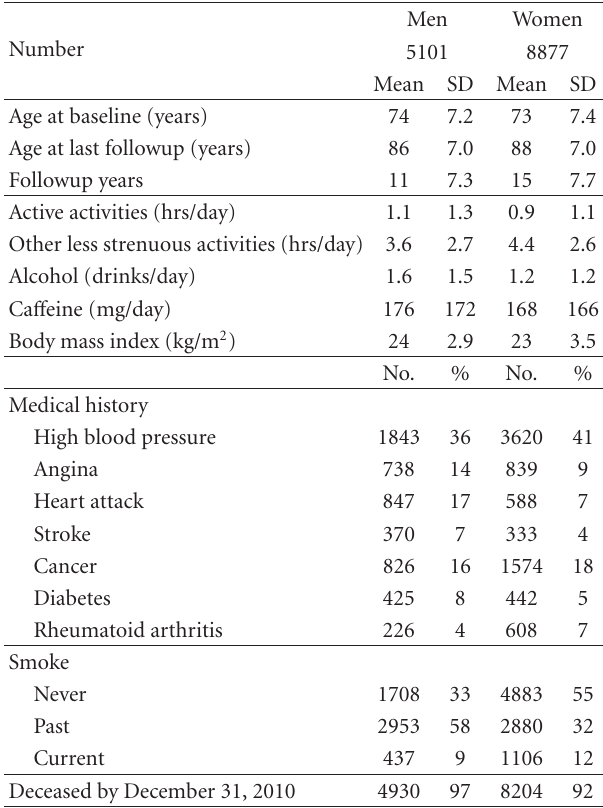
Table 1: Characteristics of participants by sex, The Leisure World